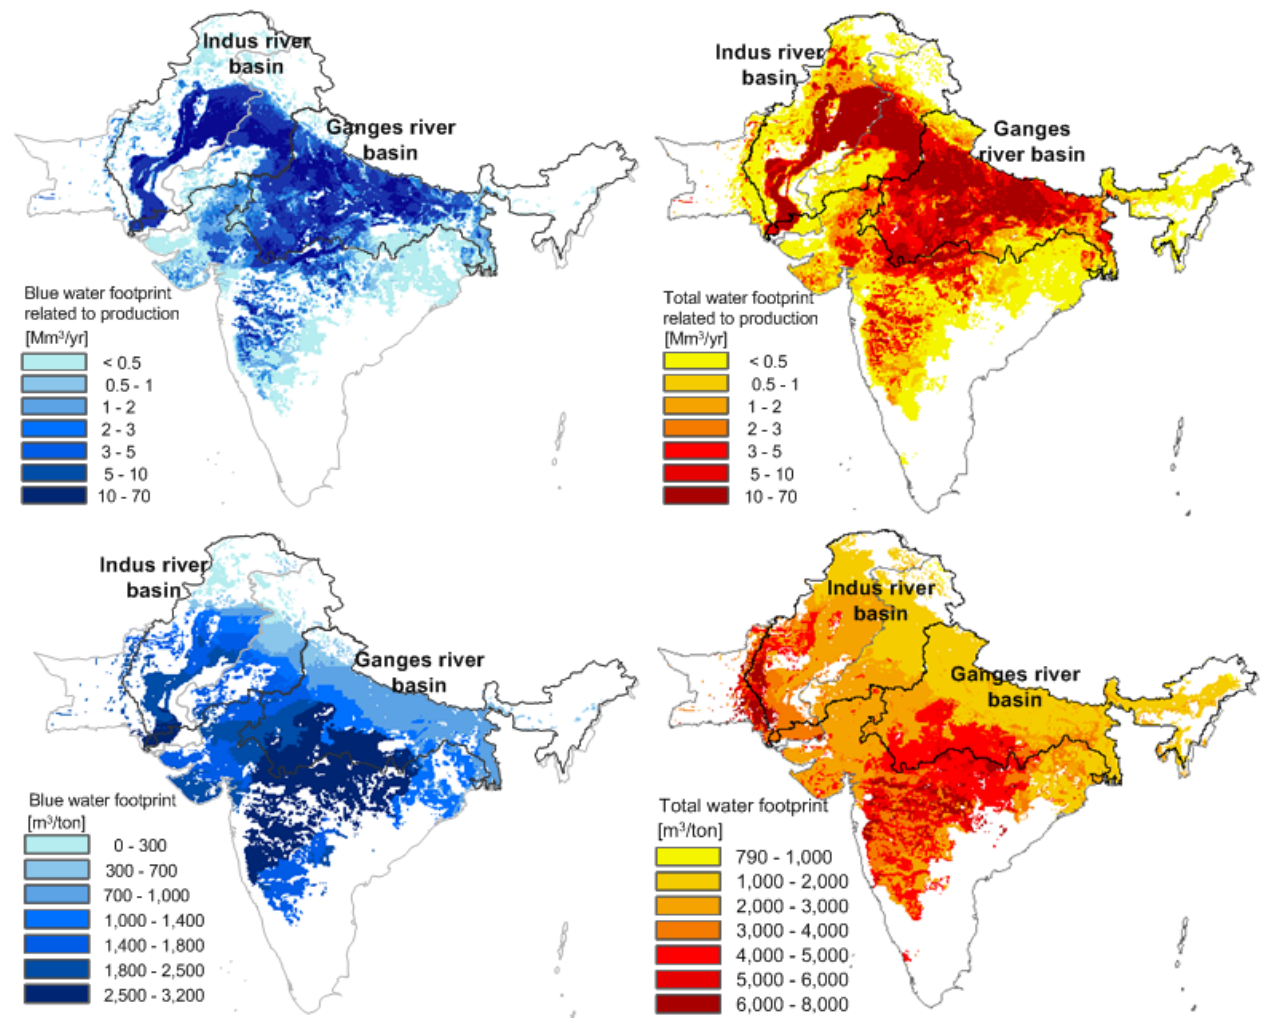
Fig. 8. The total and blue water footprint related to wheat production in India and Pakistan, both expressed as a total (Mm 3 /yr) and per ton of wheat (m 3 /ton). Period: